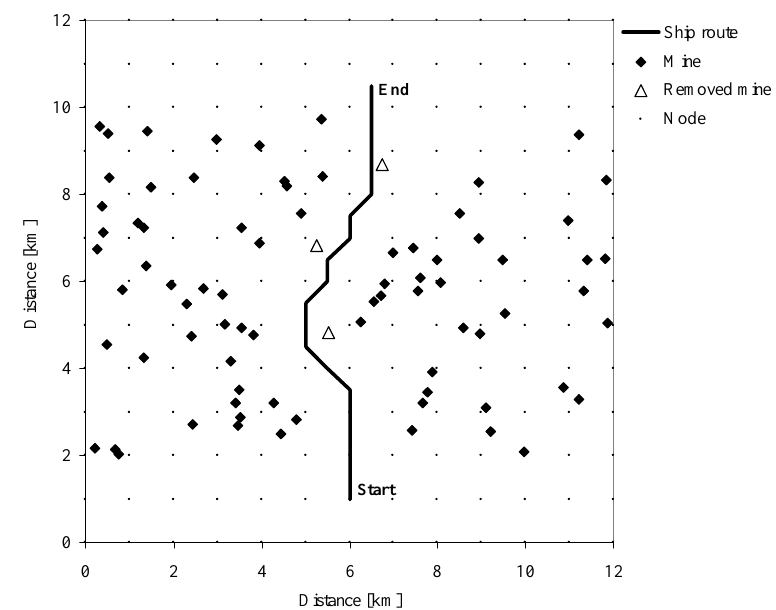
Figure 11: Safe ship route and sea mines to be neutralised following a GA optimisation (risk weighting = 0%, grid spacing = 500m, safety radius = 100m, for clarity only every second grid point is